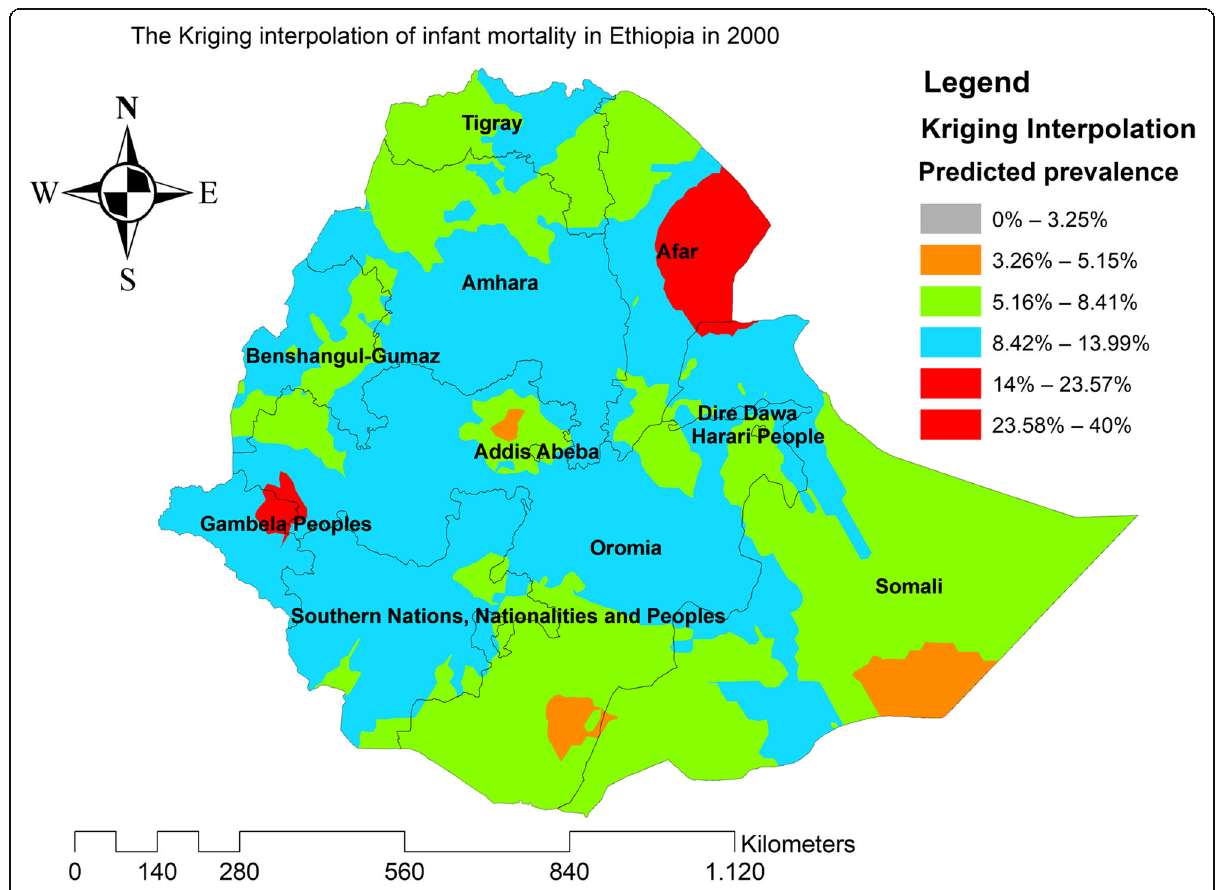
Fig. 6 The Kriging interpolation of infant mortality in Ethiopia